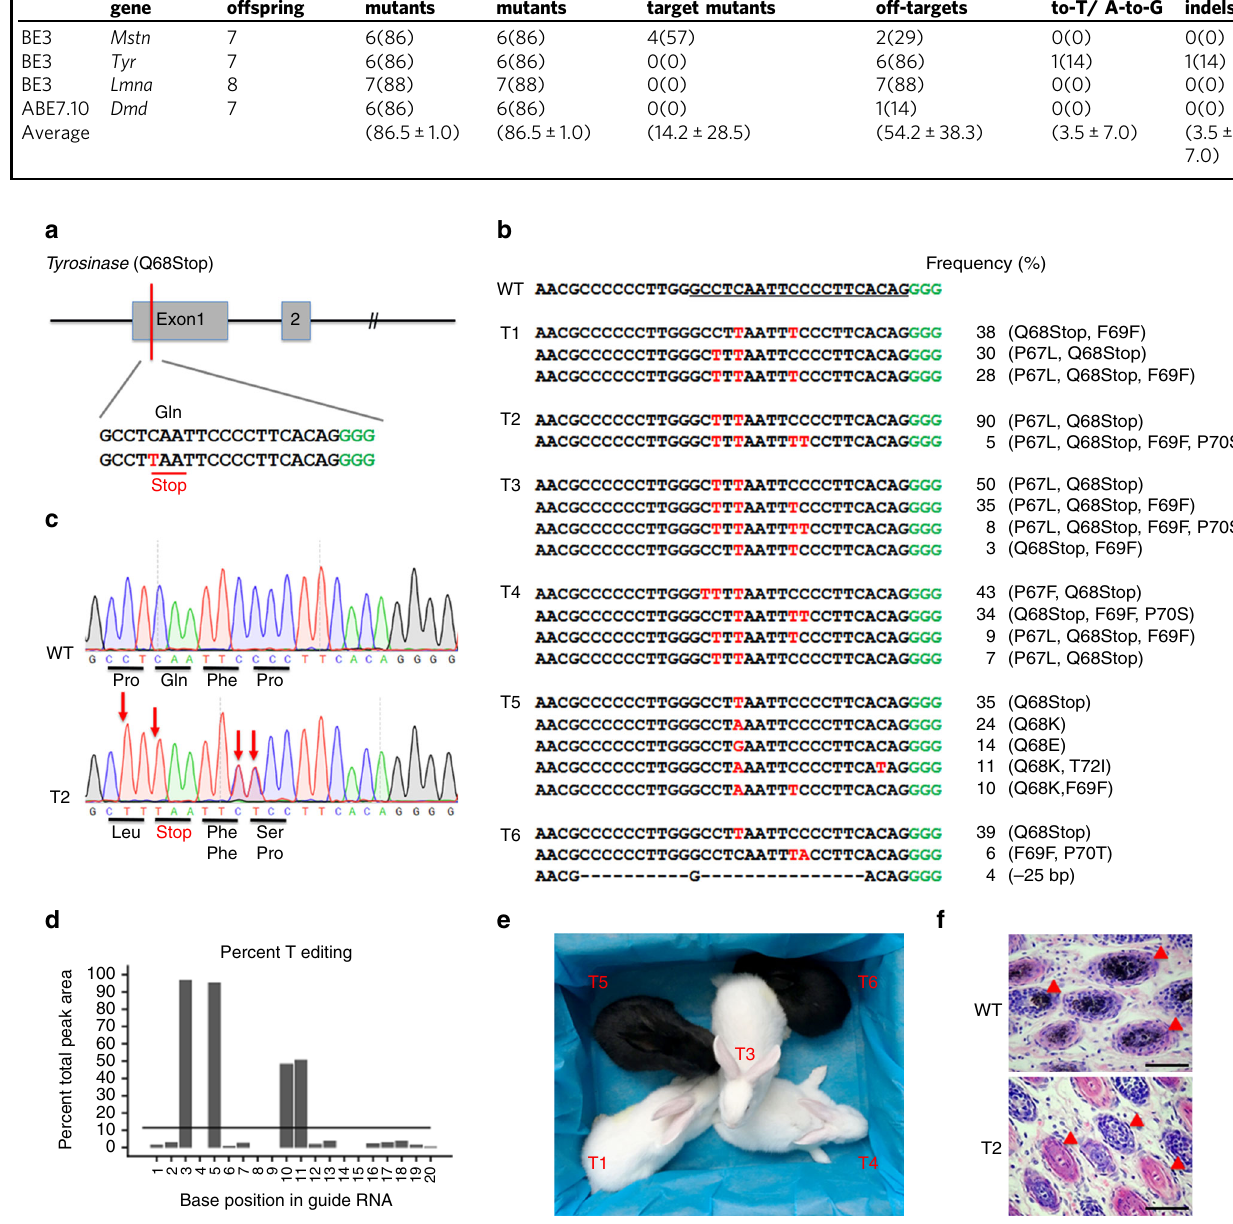
Fig. 3 Generation of an albinism rabbit model using BE3 system. a The target sequence at the Tyr locus. The PAM- and sgRNA-target sequences are shown in green and black, respectively. The substituted bases are marked in red. b Alignments of mutant sequences from targeted deep sequencing. The targeted sequence is underlined. PAM site and substitutions are shown in green and red, respectively. The column on the right indicates frequencies of mutant alleles. WT wild-type. c Sanger sequencing chromatograms from WT and Tyr mutant rabbits (T2). The red arrow indicates the substituted nucleotide. The relevant codon identities at the target site are presented under the DNA sequence. d The predicted editing bar plot based on Sanger sequencing chromatograms from T2 by EditR. e Tyr mutant rabbits with homozygous nonsense mutations exhibited a systemic albino phenotype (T1, T3, and T4). f H&E staining of skin from WT (T7) and Tyr mutant (T2) rabbits. The red triangle highlights the melanin in the basal layer of the epidermis. Scale bars: 50 μ